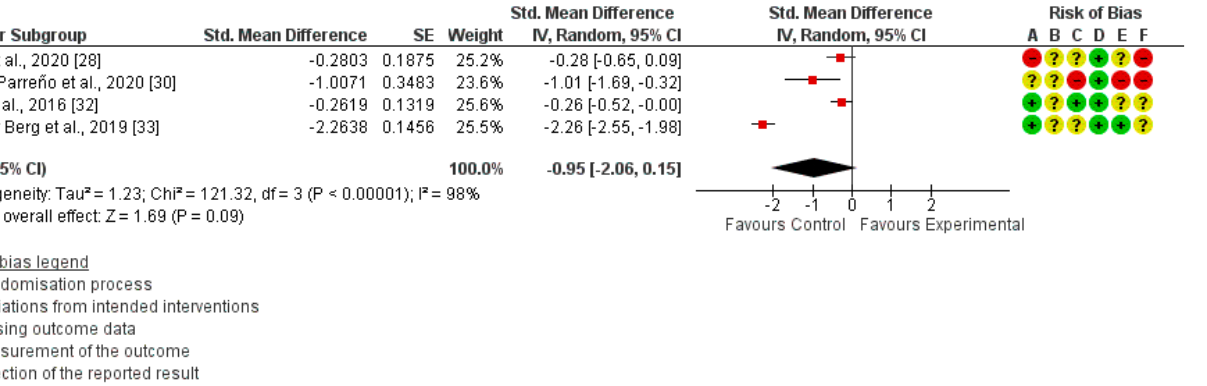
Figure 3. Forest plot of in − school Sedentary Behavior .